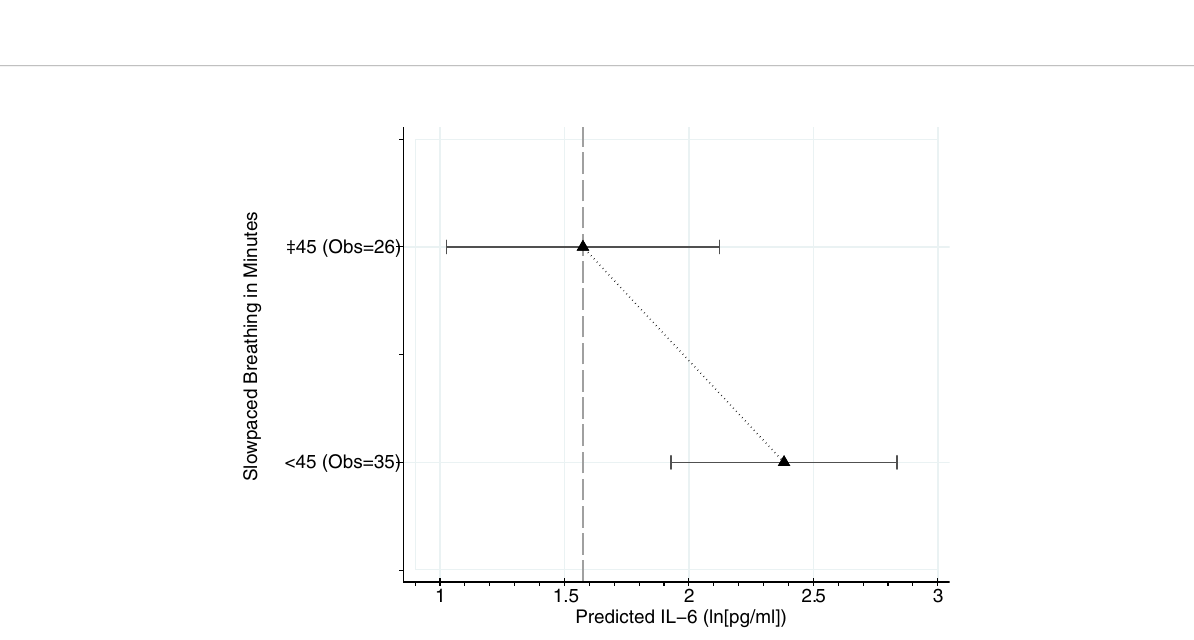
FIGURE 3 Dose response analysis using categorized breathing minutes from 22 patients and 61 days. Marginal mean values from multilevel mixed-effect linear regression models adjusted for relevant comorbidities (no vs. yes), COVID-19 pneumonia medication (count), and age (years). Prediction at covariate mean values. Obs. = Observations (Days of breathing practice).